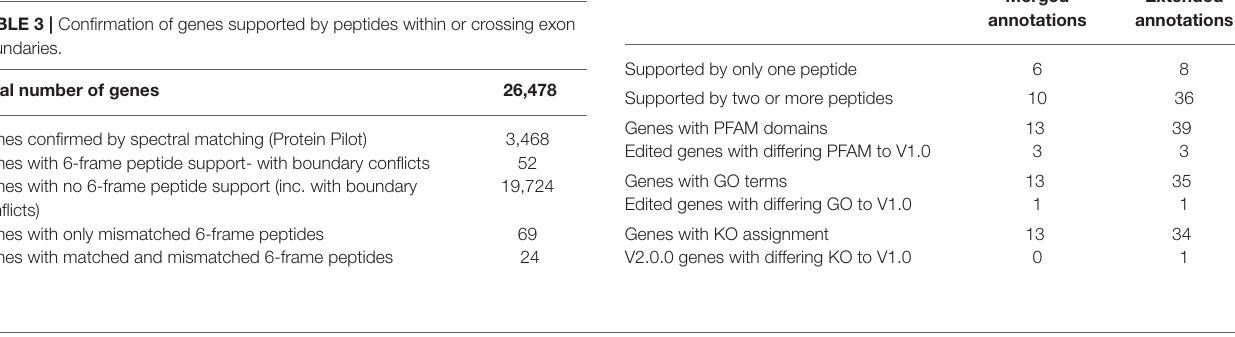
TABLE 4 | Summary of frame matches of peptides with nearby CDS features and number of significant Blastp and tBlastn hits (E value > 1E − 3 ) and number of gene features